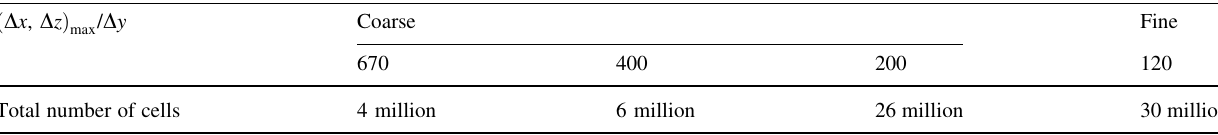
Fig. 1 Computational domain and boundary conditions ( a ) for validation study [16] (not to scale) and overview ( b ) and detail ( c ) of the meshes for the cavity model, i.e. aspect ratio 100 Table 1 Mesh criteria for each cases for the cavity